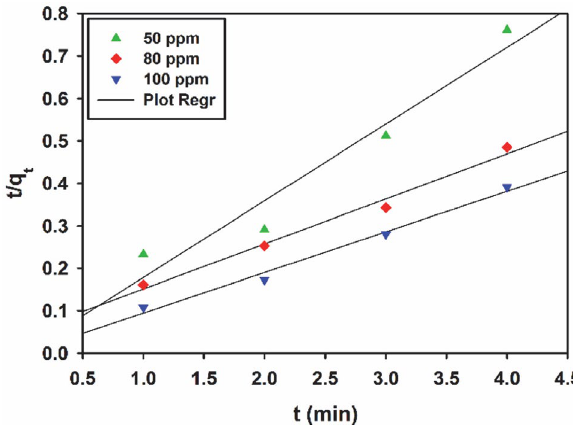
Figure 12. Results of the pseudo first-order reaction rate